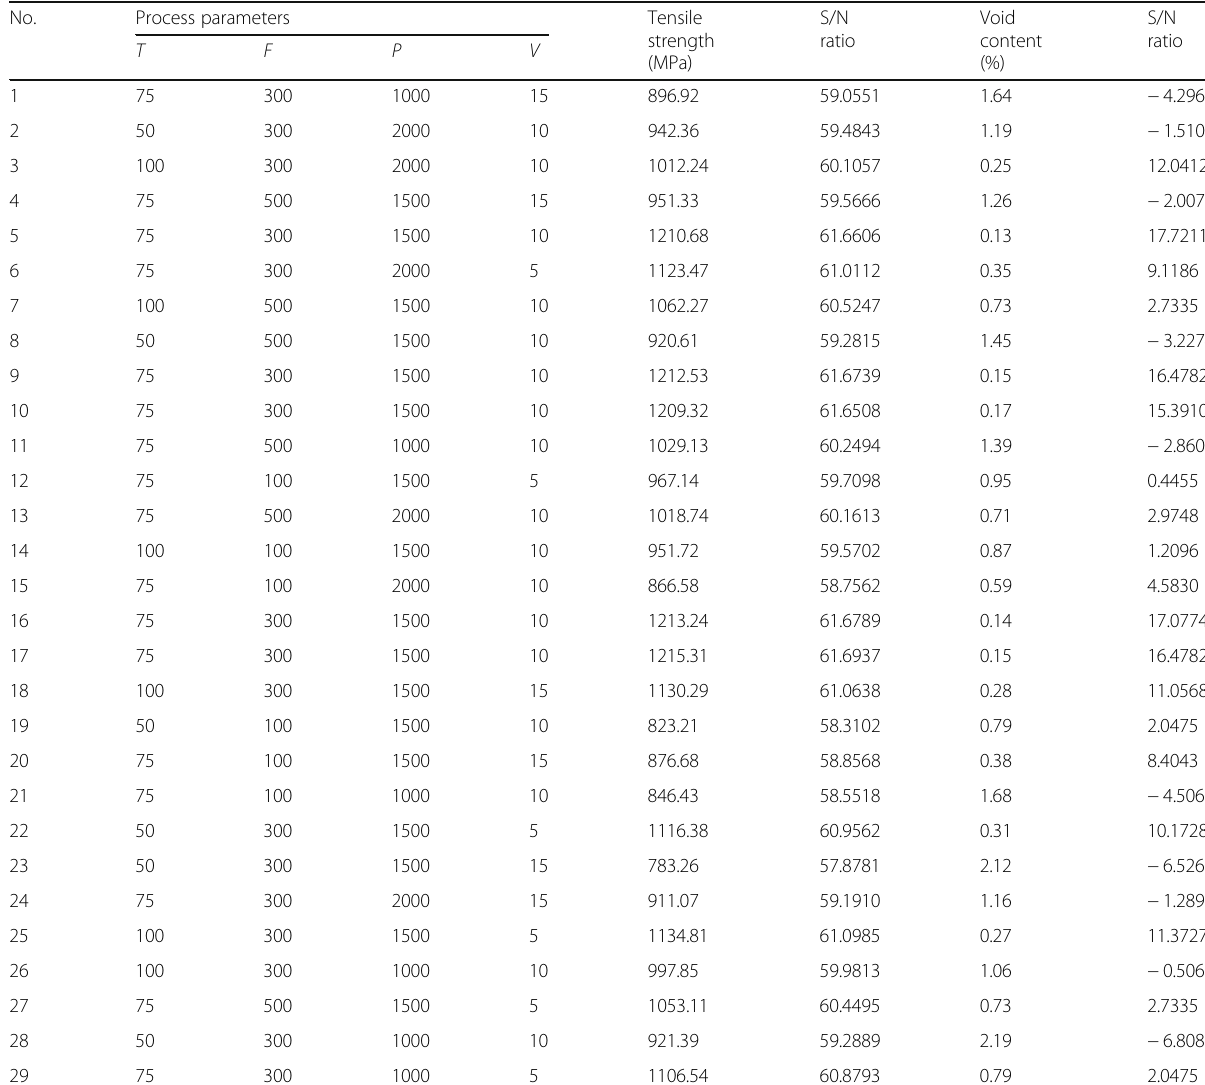
Table 2 Experiment and measurement results